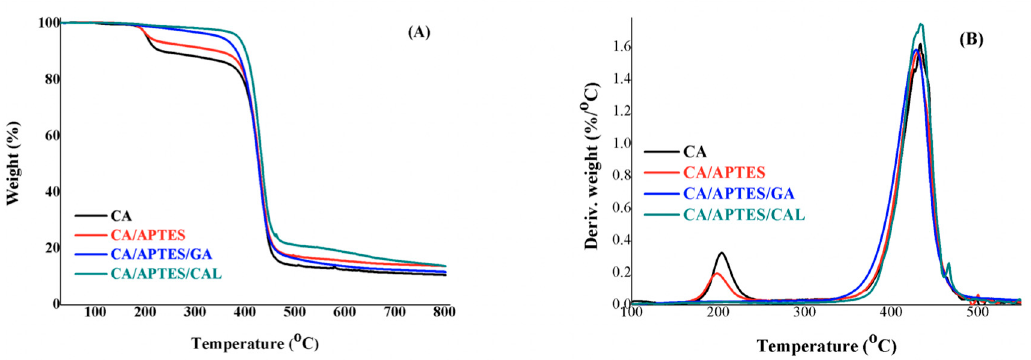
Figure 9. TGA ( A )– Differential Thermal Analysis DTA ( B ) spectra of CA, CA/APTES, CA/APTES/GA, and CA/APTES/CAL membranes.